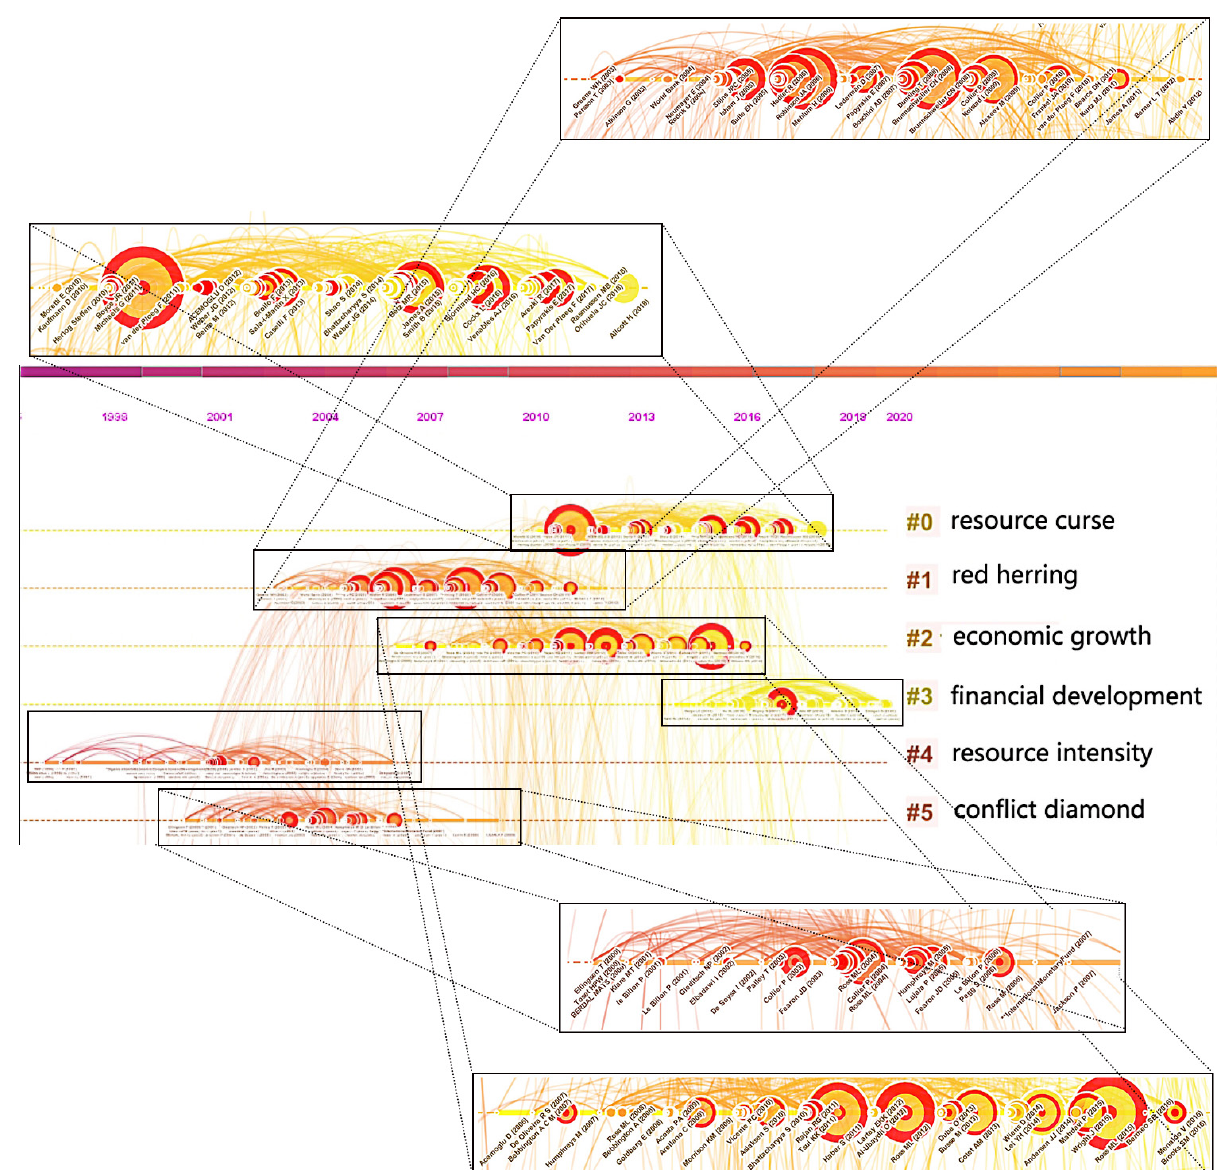
Figure 19. A timeline image of the reference co-citation framework from 1993–2020. According to the publication time, from left to right, all clusters could be identified. Three node styles are of special attention, i.e., large nodes display references strongly cited, tree rings nodes indicate critical experiments of citation explosions, and purple tree rings nodes have robust core